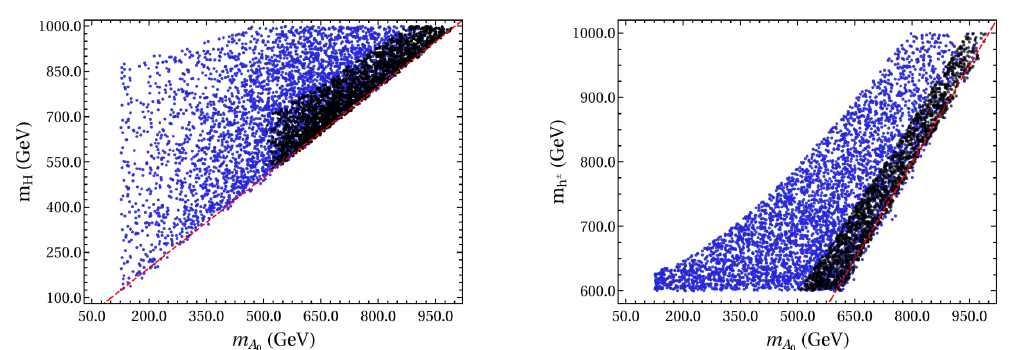
Figure 9 . In both figures, blue points complies with theoretical constraints with the choice λ max = √ 4 π , while for the black points we choose λ max = 4 π . The dashed red line is for degenerate